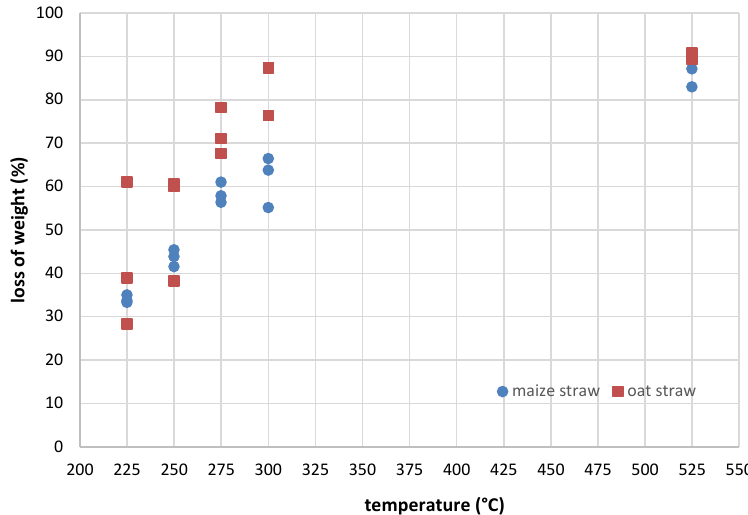
Figure 19. Mass loss of maize and oat straw after torrefaction process in CO 2 atmosphere using electrical furnace.